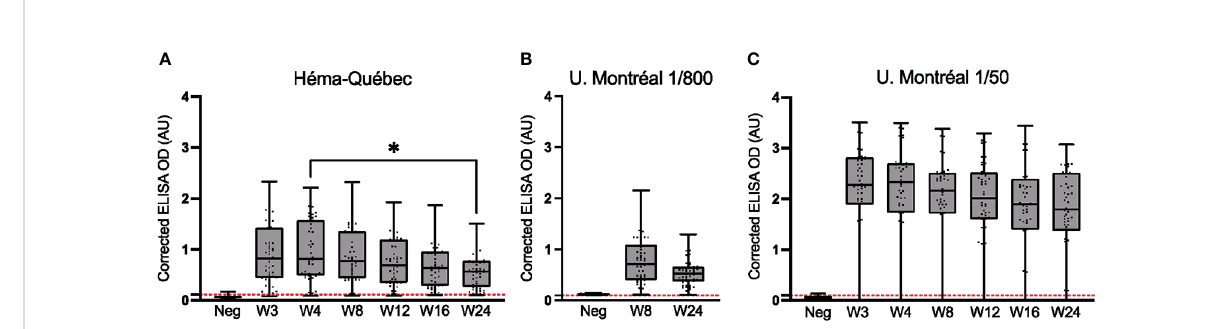
FIGURE 1 Comparative longitudinal assessment of anti-spike (Wuhan-Hu-1 strain) IgG. ELISAs using serum samples from n = 50 SARS-CoV-2-positive (PCR-con fi rmed) individuals who remained unvaccinated throughout the study and attended all or most visits. (A) Assays were performed for samples collected from weeks 3 to 24 at the HQ site. Serum dilutions used in (A) are listed in Table 1. (B) The subset of assays for weeks 8 and 24 was repeated at the UdeM site, using the same clinical samples, dilution and secondary antibody as in (A) . Serum was at 1/800 dilution (Table 1). (C) Assays for weeks 3 to 24 were repeated at the UdeM site, using a different secondary antibody and different dilution of the antibody, and a 1/50 dilution of serum. Anti-IgG secondary antibodies used are listed in Table 2. The average of triplicate assays is given as